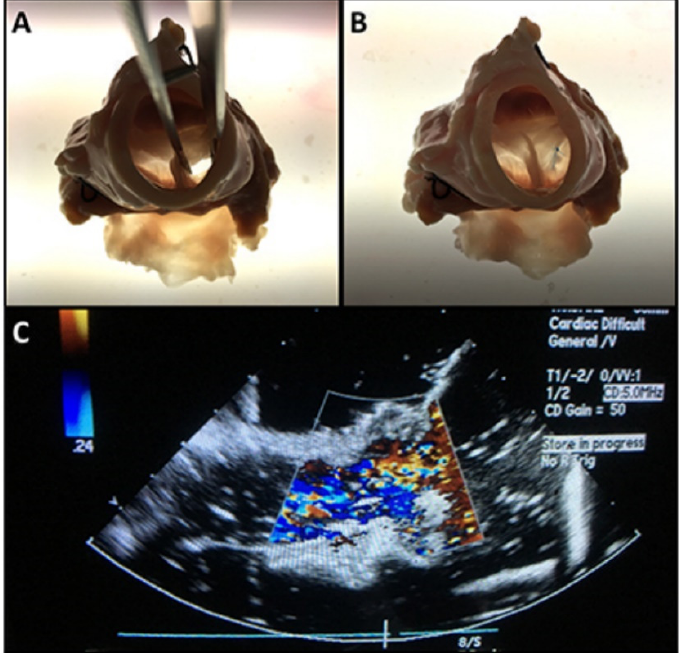
Figure 7. Part two of the procedure in which holes in the aortic valve leaflets were repaired. ( A ) The iatrogenic hole in the aortic valve leaflet. ( B ) The repaired hole in the leaflet by use of patch. ( C ) Echocardiogram showing the flow across the repaired aortic valve in the simulator.